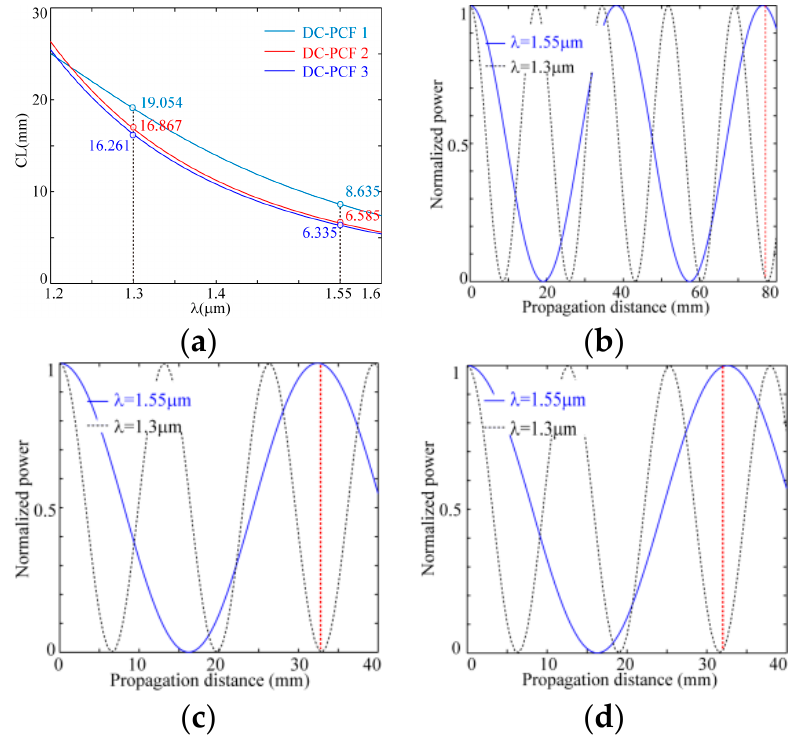
Figure 9. The variation relation of CLs with wavelengths on the LHP modes for the three DC-PCFs corresponding to Figure 8 in ( a ) and the normalized power variation along the propagation distance in core A in the three DC-PCFs for λ = 1.55 µ m and λ = 1.30 µ m in ( b – d ). and 6.335 mm at λ = 1.55 µ m and 19.054 mm, 16.867 mm and 16.261 mm at λ = 1.30 µ